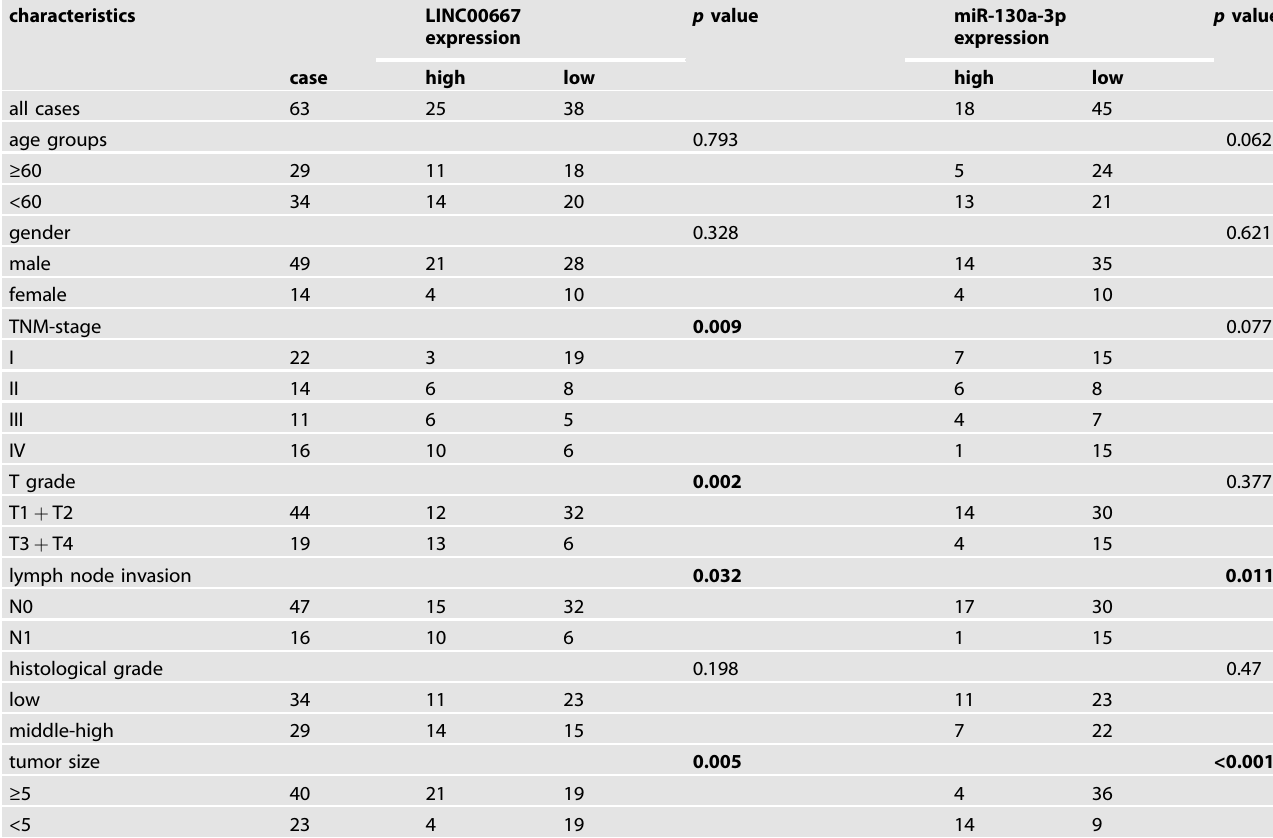
Table 1. Correlation between expression of LINC00667 and miR-130a-3p and clinicopathological characteristics in HCC tissues.